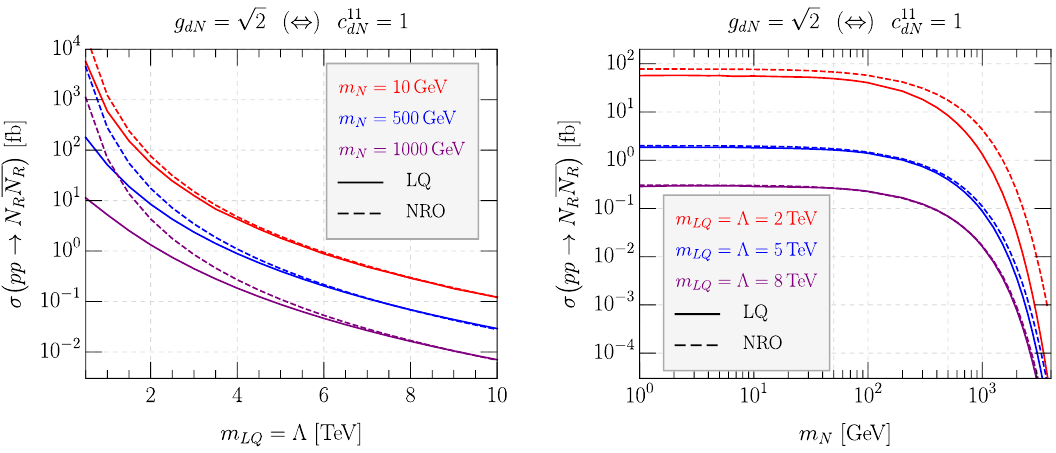
Figure 1 . Cross sections for pair production of HNLs N R via O dN as function of m LQ = Λ (left) and m N (right). The plots compare the calculation using c 11 the cross sections of a LQ model (for S d with the first generation g dN = to the matching of the two models via a Fierz transformation. The plots are valid for Dirac